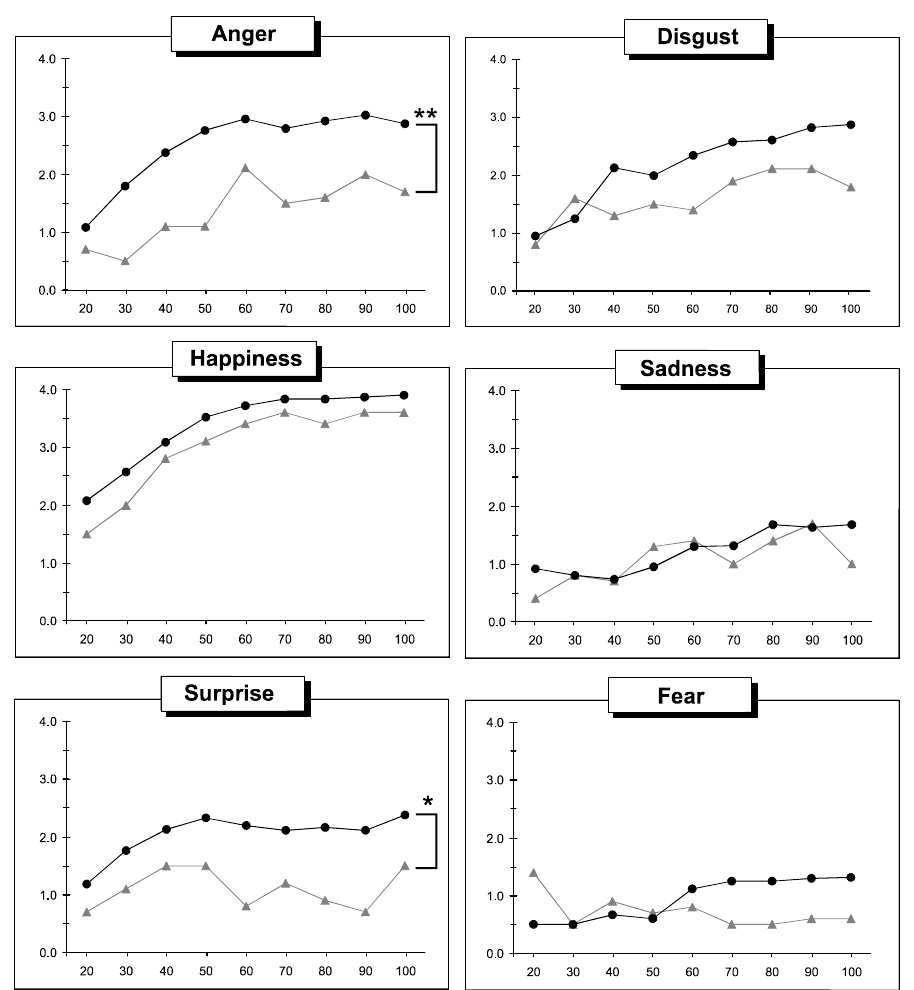
Fig. 2. Mean performance (y-axis, number correctly identified emotions) of the FTLD patients (grey triangles) and the healthy controls (black circles) on nine end points of emotional intensity (x-axis, 20–100%) for the six different emotions (maximum score for each intensity per emotion type = 4); Levels of significance: * p < 0 . 002 , ** p < 0 . 0005